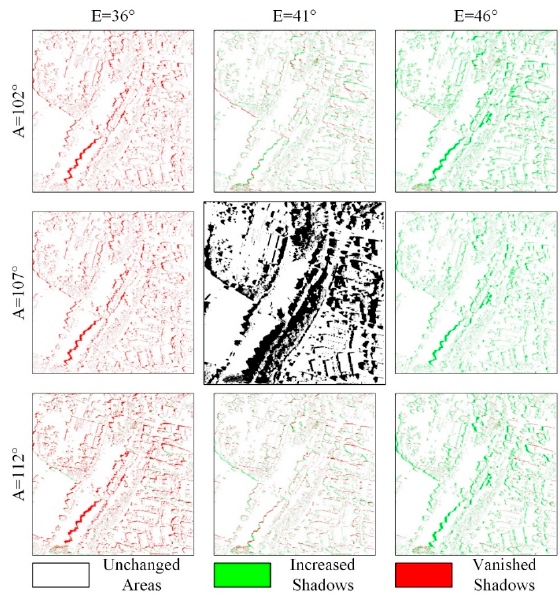
Figure 9. The influence of error in the solar position. Table 9. The error generated by the solar position.